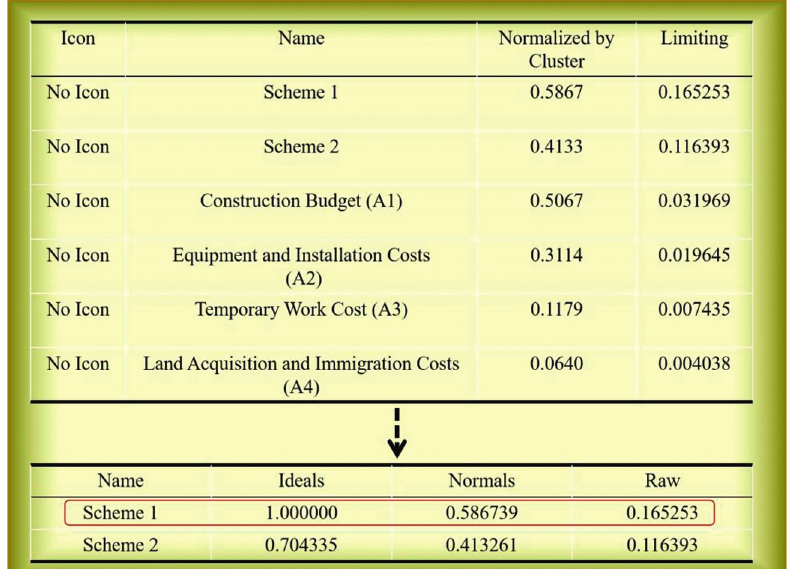
Figure 2: Priority and results of scheme